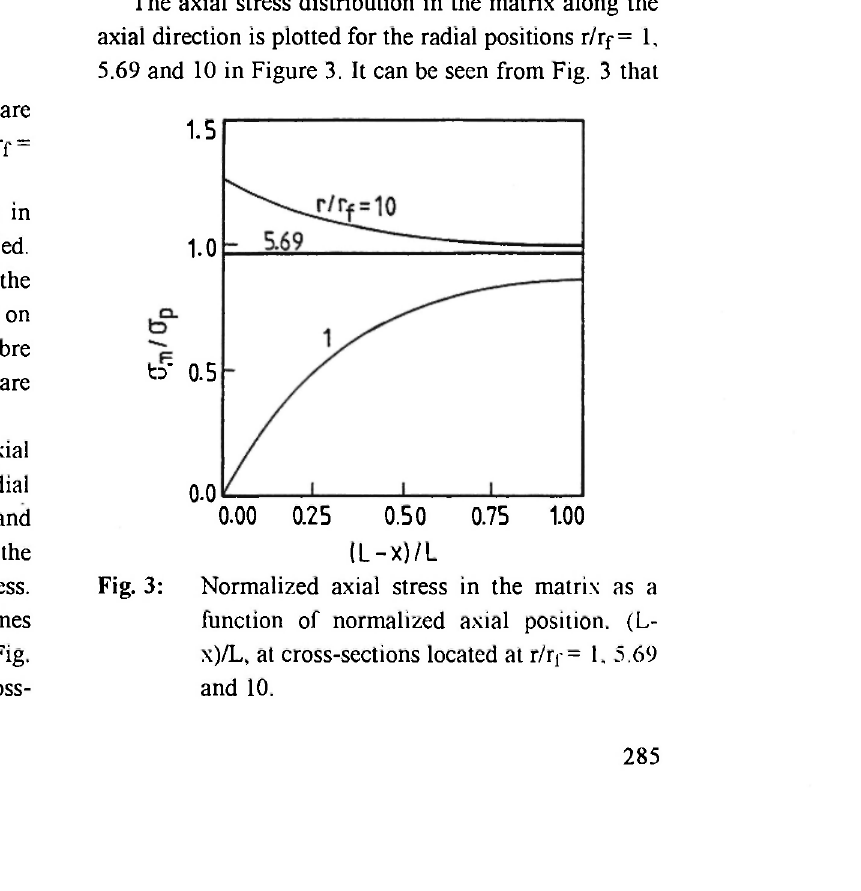
Fig. 2: Normalized axial stress in the matrix as a function of normalized radial position, r/rf, at cross-sections located at x/rf = 0, 8 and 10. sections at the two ends of the fibre (i.e., at χ = ±10rf). The stress is the most uniform at the central cross- section of this model (i.e., at x/rf = 0). When r/rf = 5.69, the axial stress in the matrix is independent of the axial position. The axial stress distribution in the matrix along the axial direction is plotted for the radial positions r/rf = 1, 5.69 and 10 in Figure 3. It can be seen from Fig. 3 that